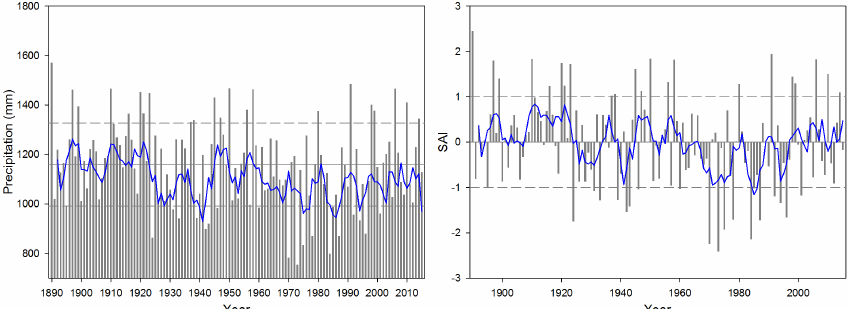
Figure 4. Mean annual precipitation (a) and the standardized anomaly index (SAI – b ) for three long-term rainfall stations including mean annual precipitation (solid line), the standard deviation (dashed line) for the entire period and the 5-year running average (blue